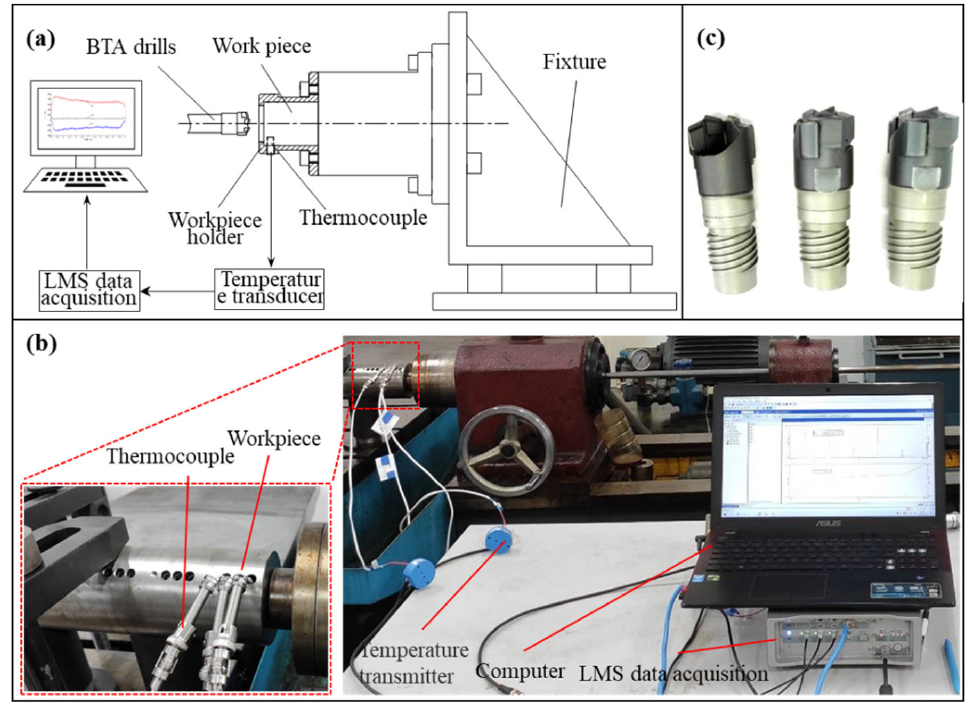
Figure 5. ( a ) Experimental principle of temperature measurement and detection. ( b ) Experimental facility. ( c ) Φ 17.75 mm staggered-tooth BTA drills.